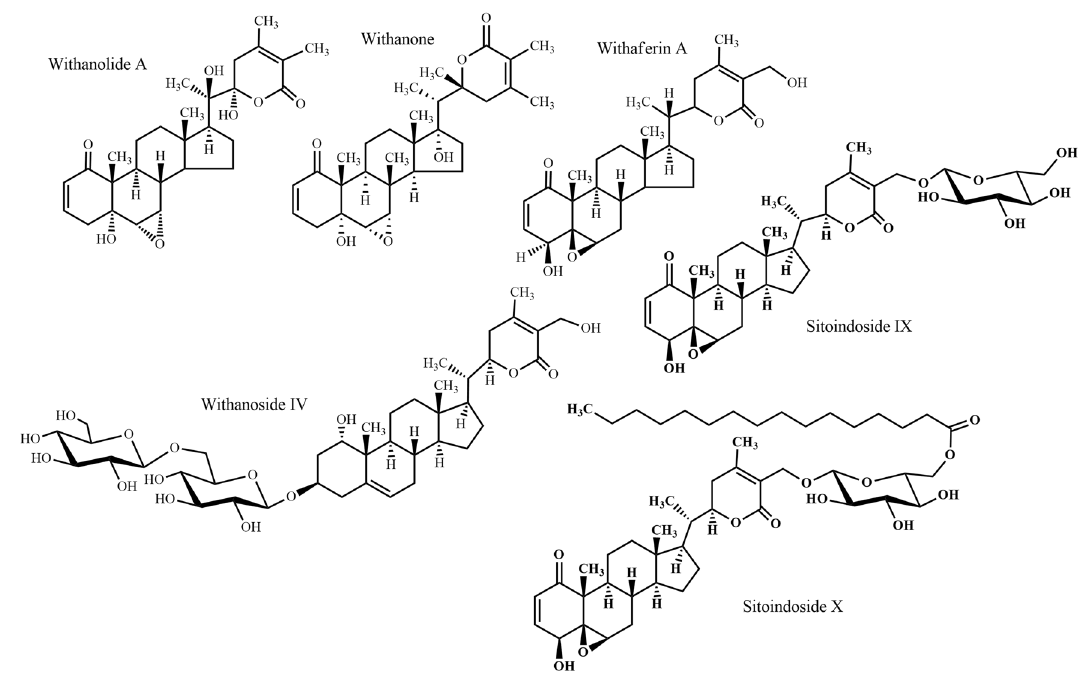
Fig. 10 Triterpenes 3: steroidal